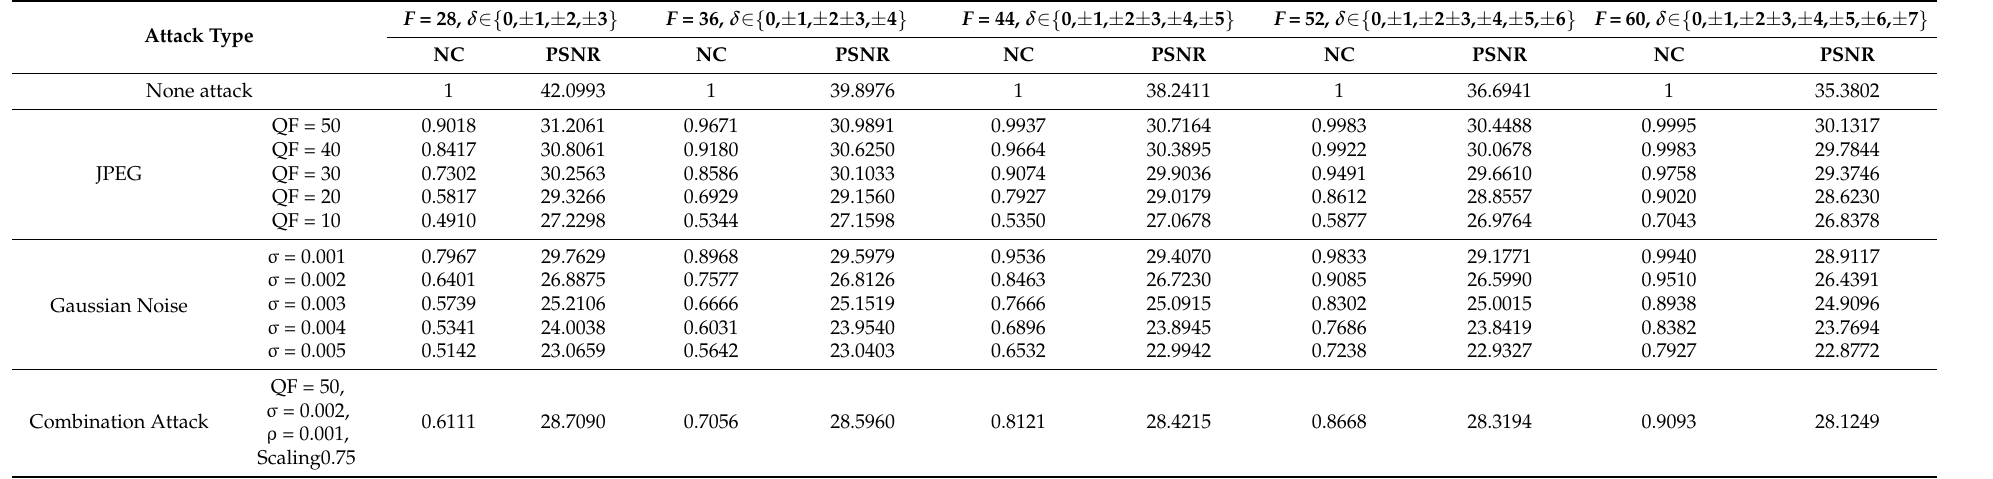
Table 3. Experimental results under different f and δ